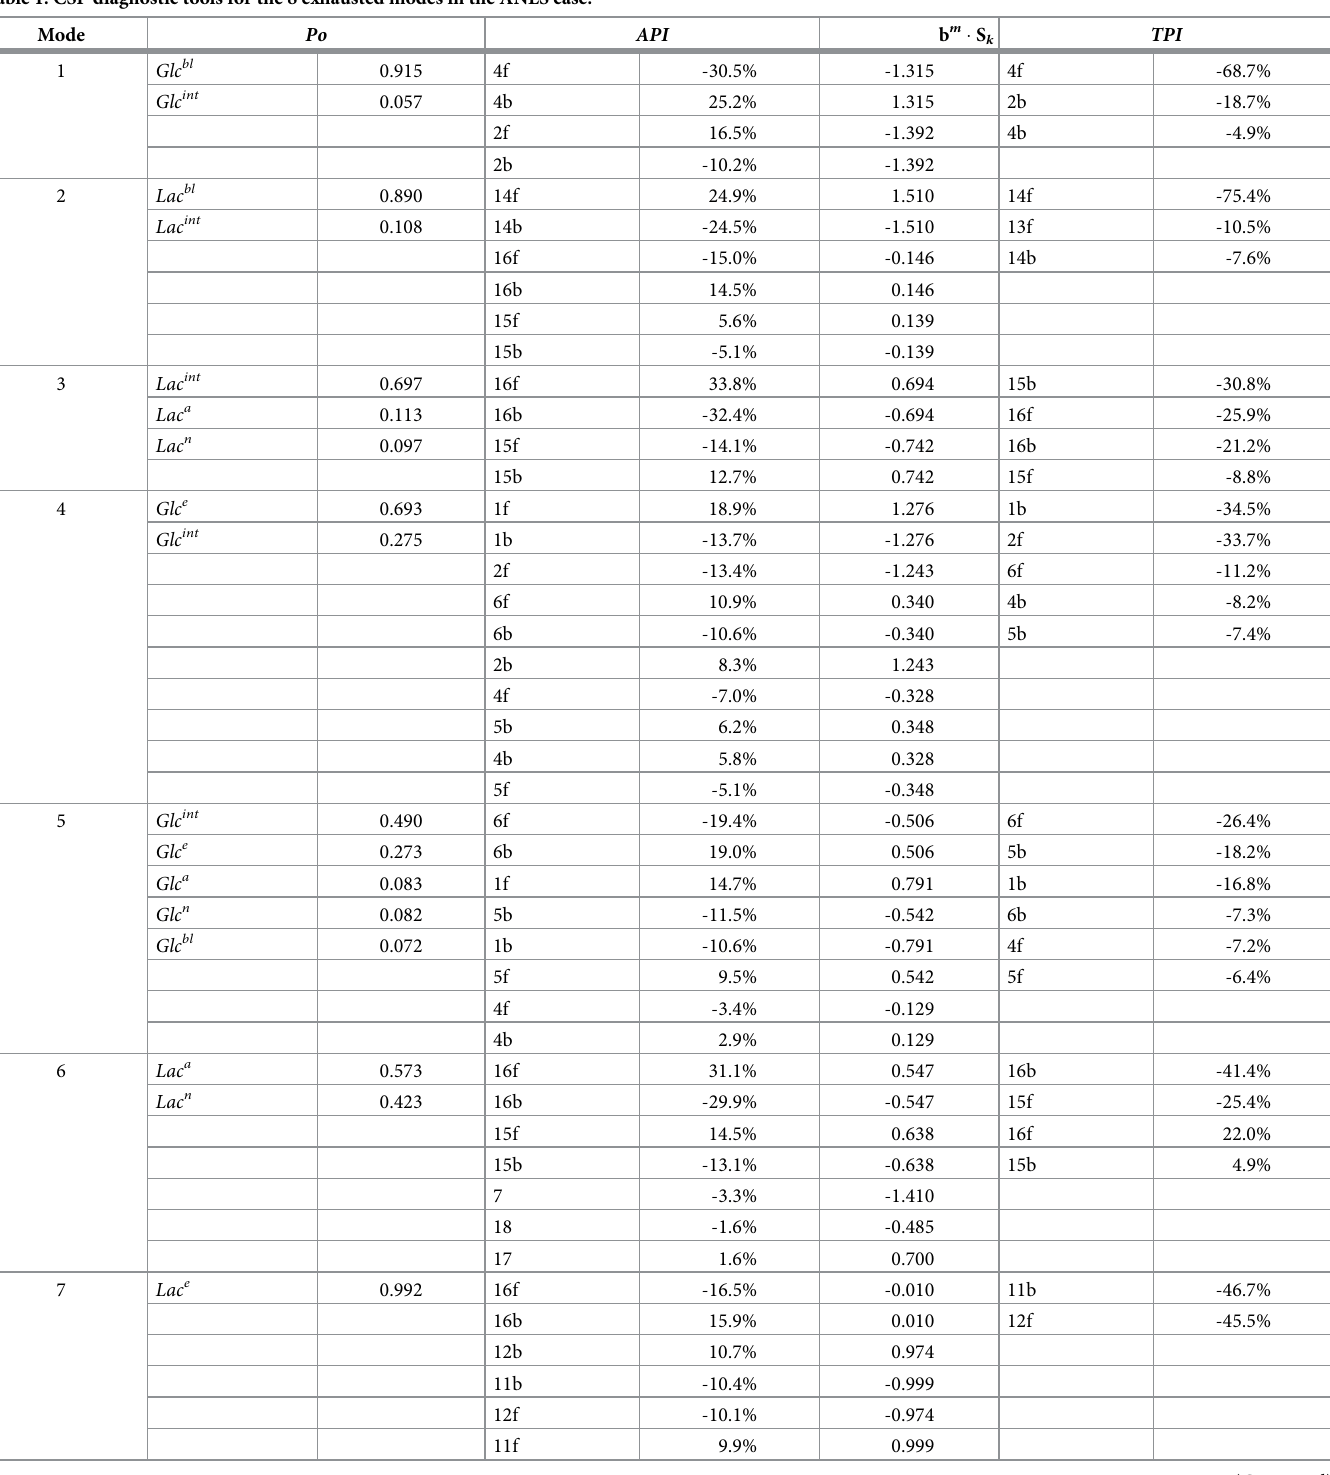
Table 1. CSP diagnostic tools for the 8 exhausted modes in the ANLS